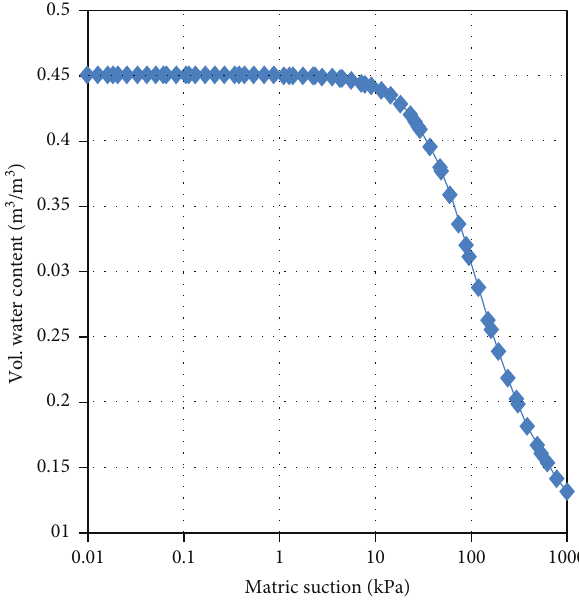
Figure 16: Soil-water characteristic curve of the Hongyanzi landslide.